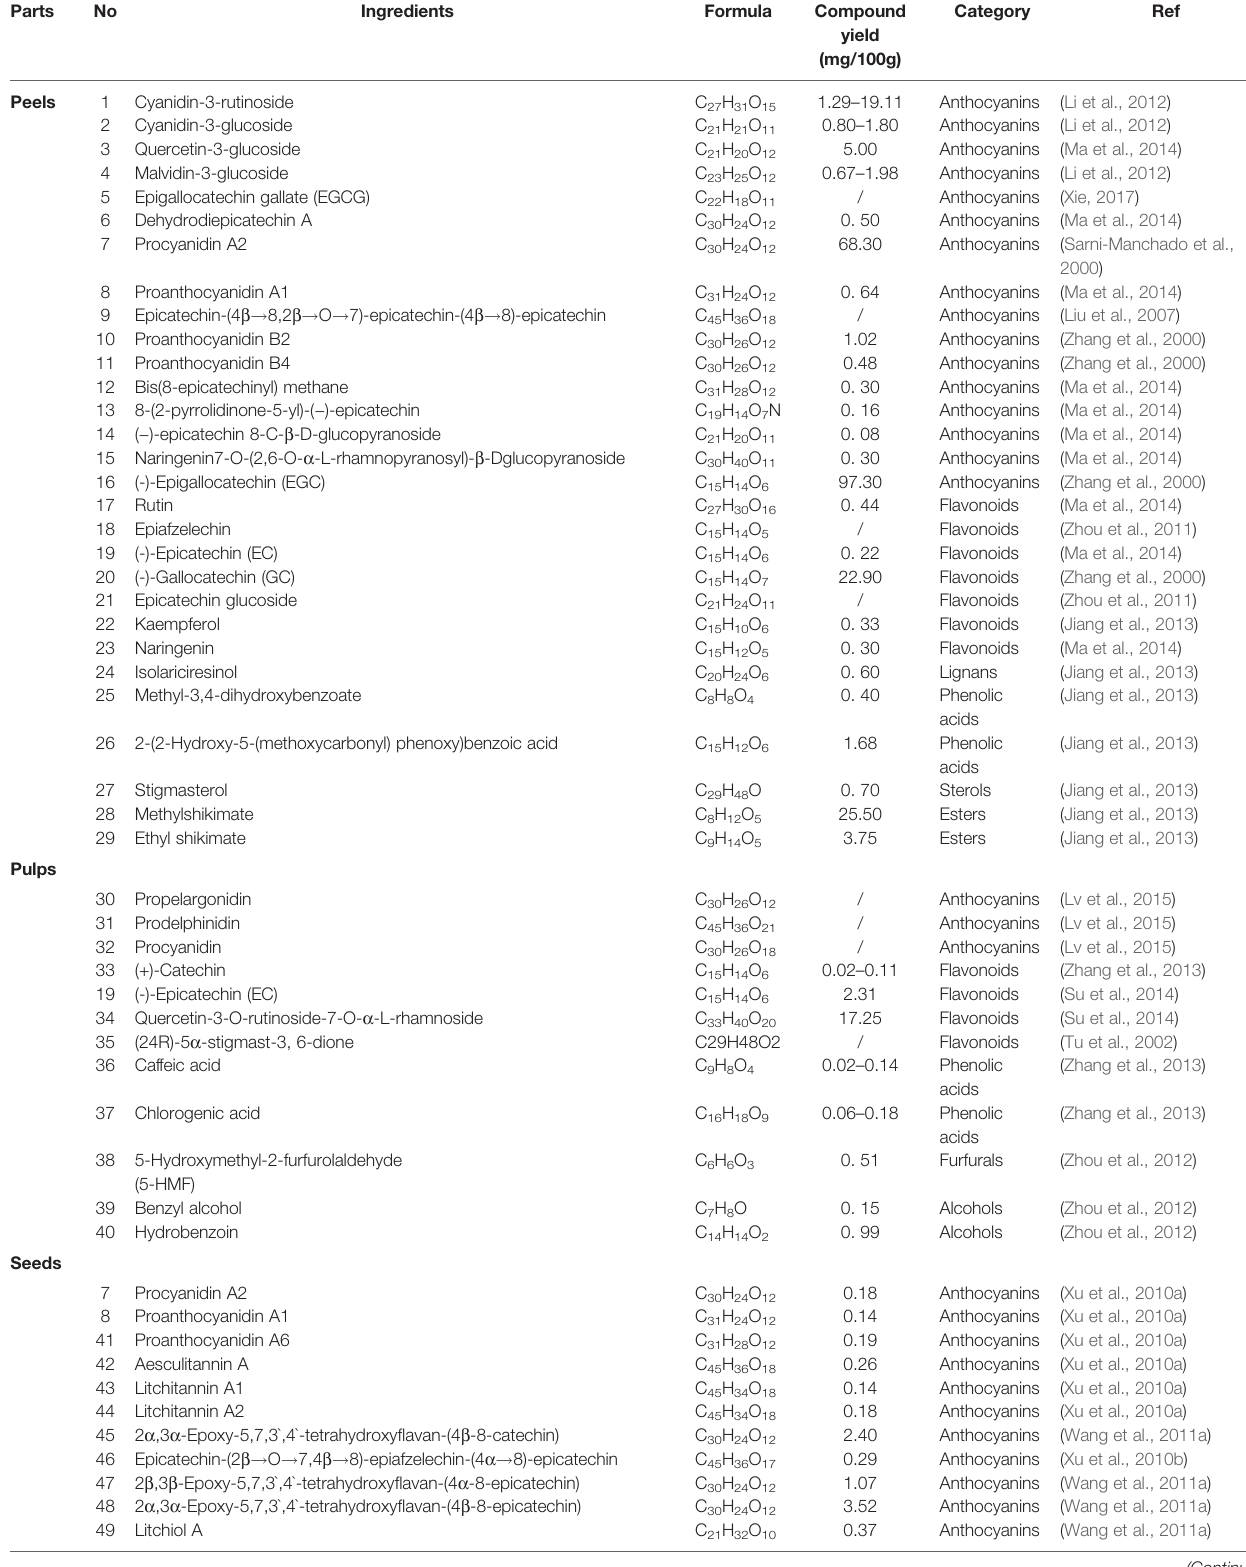
TABLE 1 | Compounds Isolated from L. chinensis